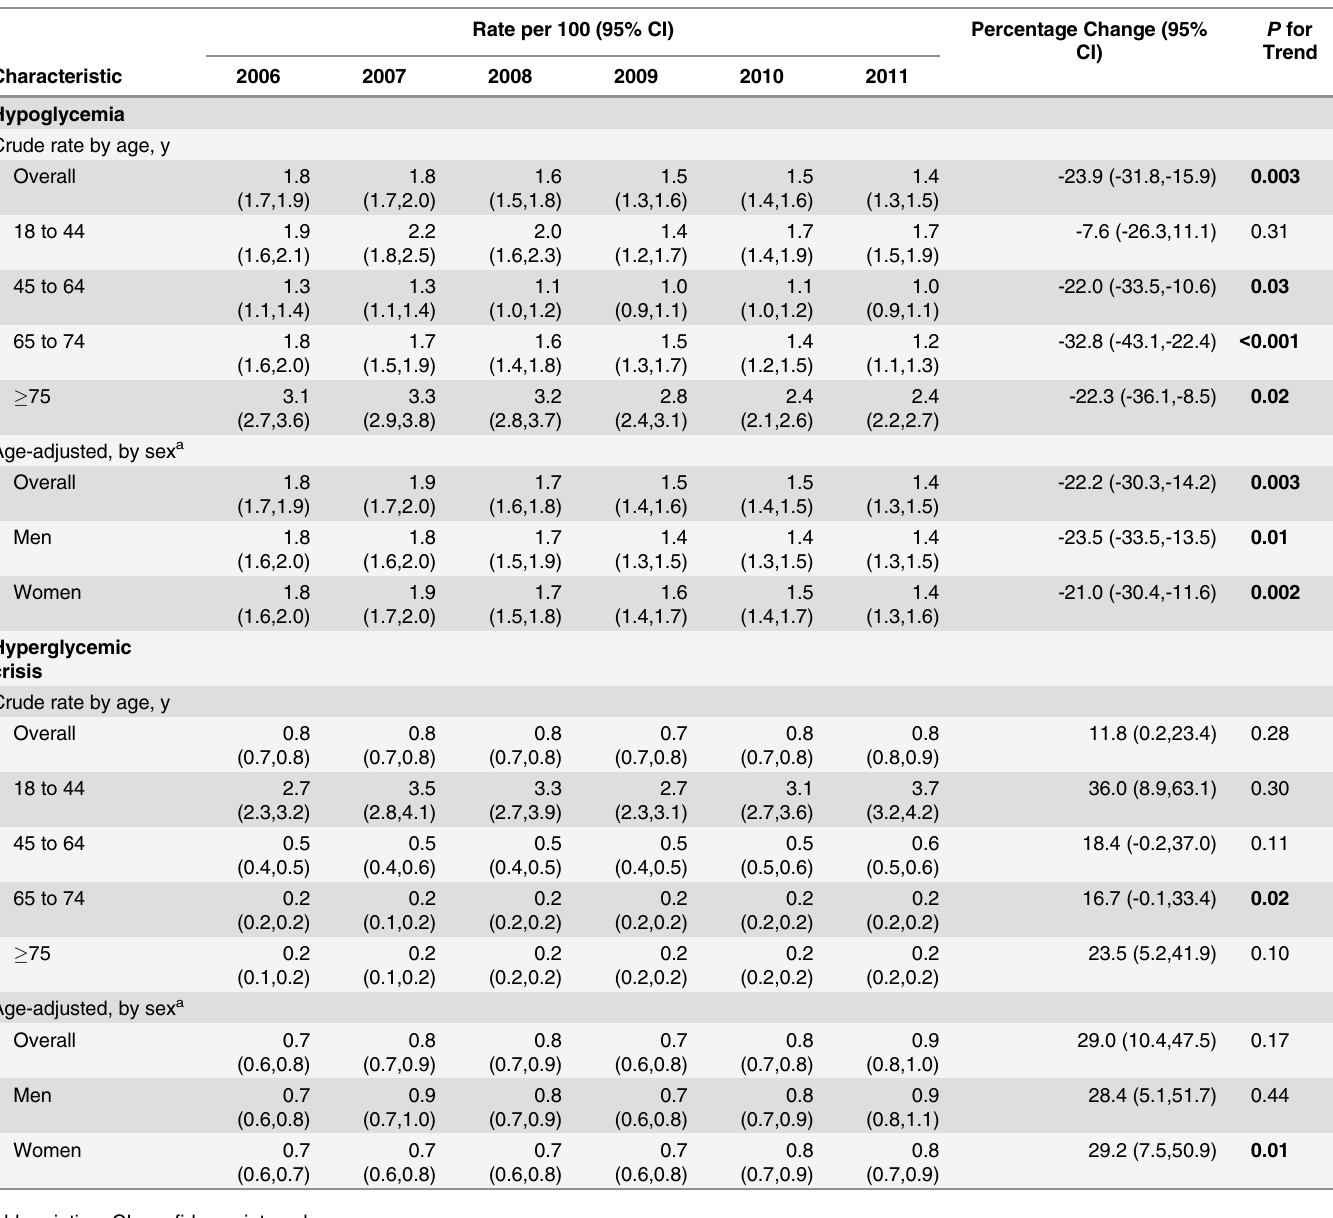
Table 2. Emergency Department Visit Rates for Hypoglycemia and Hyperglycemic Crisis Among Adults With Diagnosed Diabetes, 2006 – 2011.